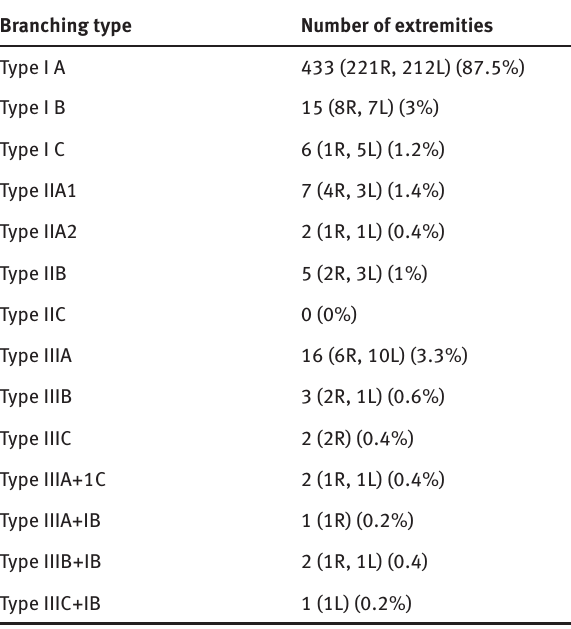
Table 1: Distribution of the popliteal artery terminal branching patterns